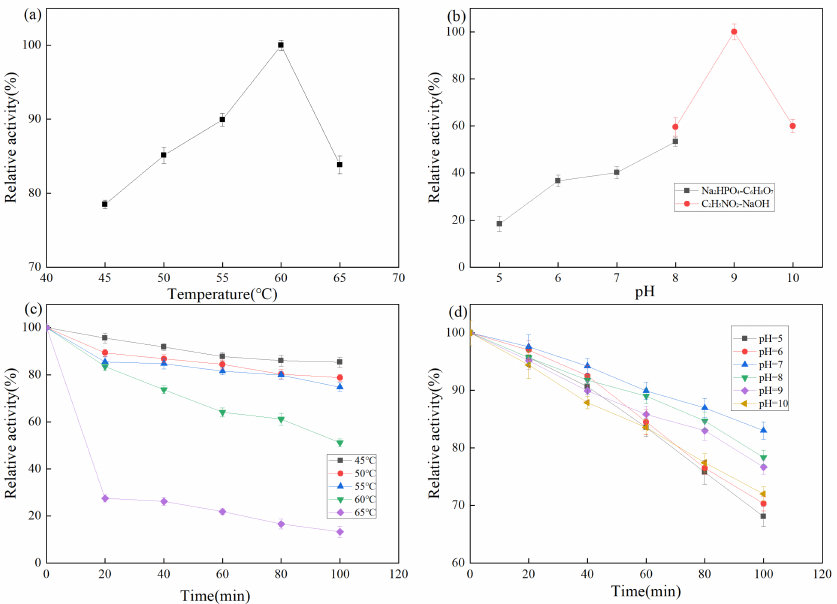
Figure 5. ( a ) Effect of temperature on enzyme activity; ( b ) Effect of pH on enzyme activity; ( c ) Effect of temperature on the stability of enzyme activity; ( d ) Effect of pH on the stability of enzyme